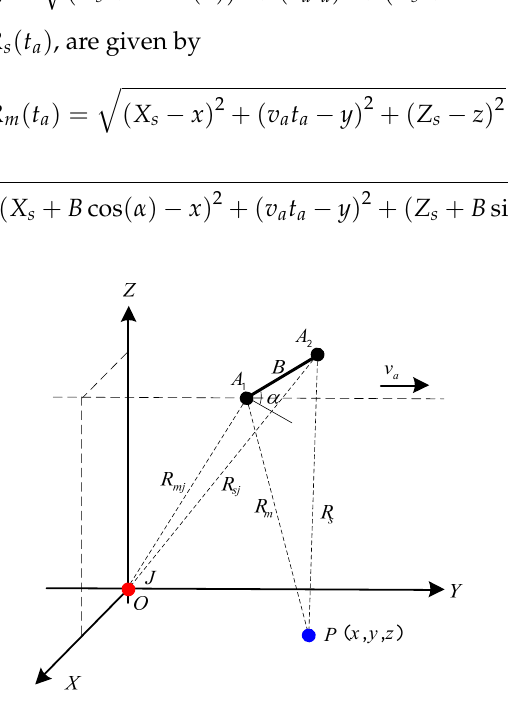
Figure 1. InSAR and jammer geometry.